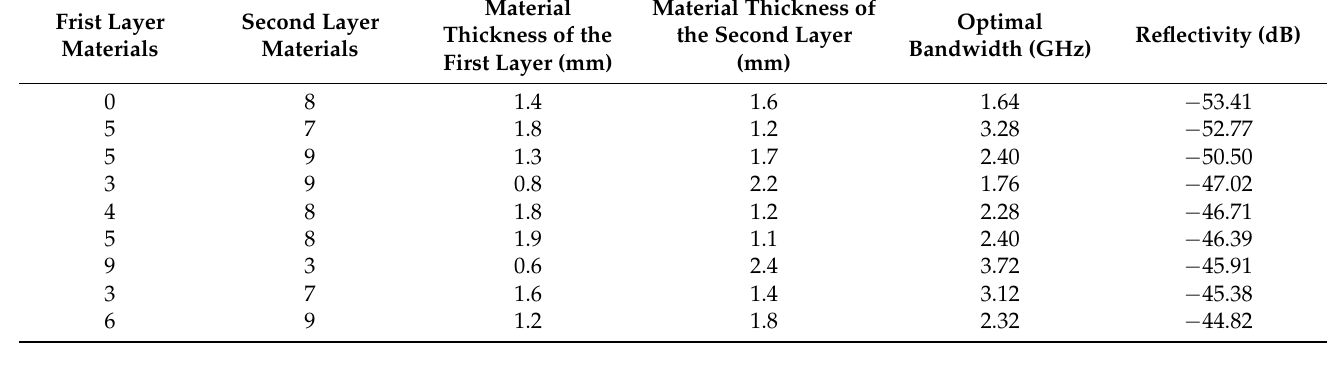
Table 3. The optimization results using objective function F2 (two-layers) of GA algorithm. Frist Layer Materials